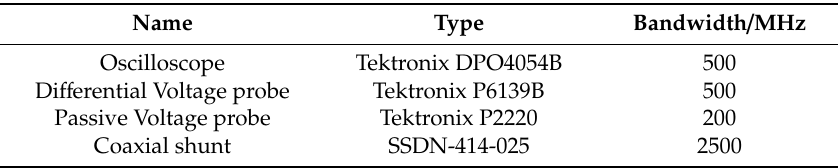
Table 5. Test equipment for the double-pulse test platform.